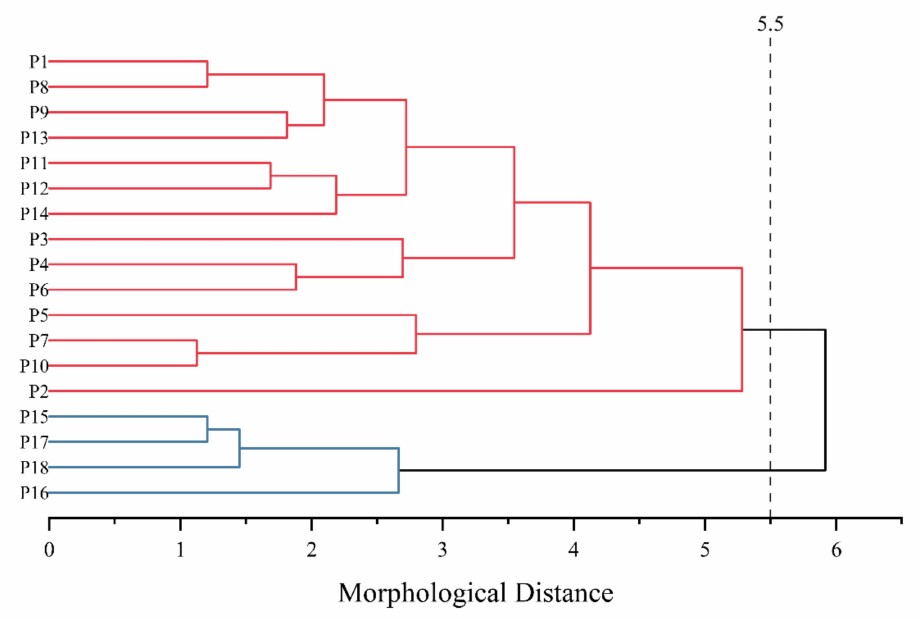
Figure 4. Cluster diagram of 18 tree peony populations based on pollen characteristics. The red line indicates subsect. Vaginatae and the blue line indicates subsect. Delavayanae